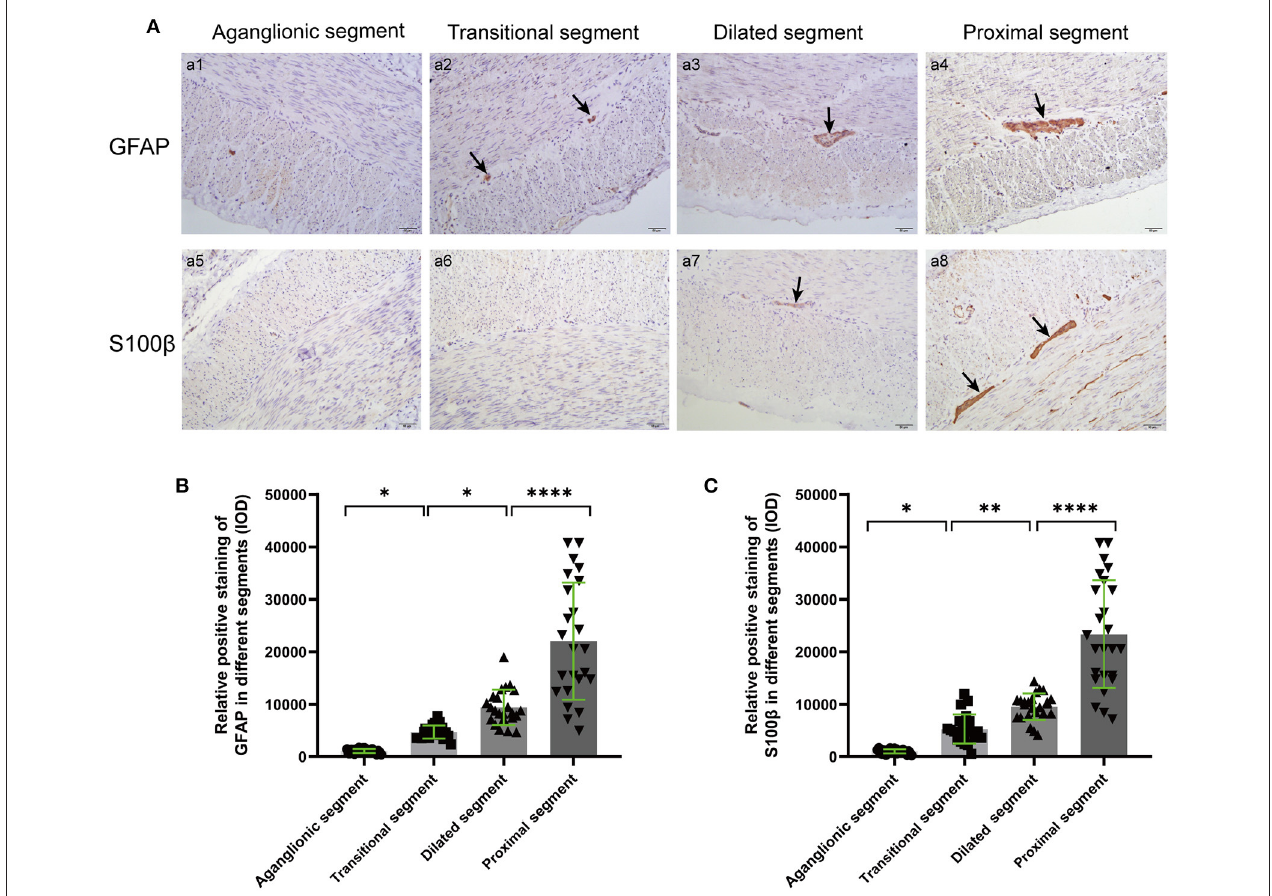
FIGURE 3 | IHC (A) and quantitative analysis (B,C) of GFAP and S100 β in the different segments of colonic muscle sections. The target GFAP and S100 β were not significantly stained in aganglionic segments (a1, a5), and the positive staining particles in transitional (a2, a6 arrows) and dilated segments (a3, a7 arrows) were significantly attenuated and irregularly shaped, compared with the proximal segments (a4, a8 arrows). (Scale bar: 50 µ m, ns, p > 0.05; * p < 0.05; ** p < 0.01; *** p < 0.001; **** p <